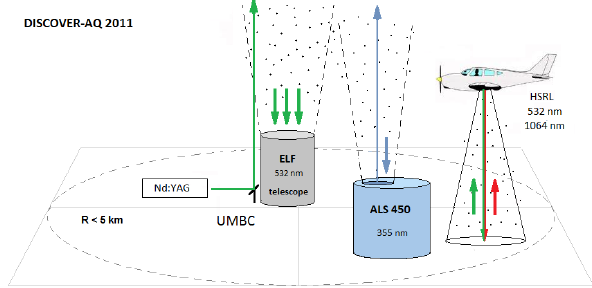
Figure 3. Setup of airborne and ground-based instruments at UMBC during DISCOVER-AQ 2011. A maximum radius of 5km was considered to construct the hybrid multiwavelength lidar data set using HSRL and ALS-450